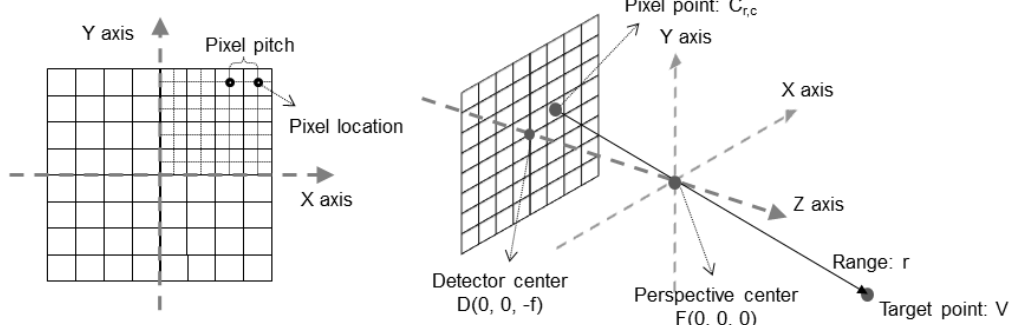
Figure 3. Sensor coordinate system and a pixel ray model. The left one is 2D view of the detector and the right figure shows 3D view. Subscript are the row and column indices